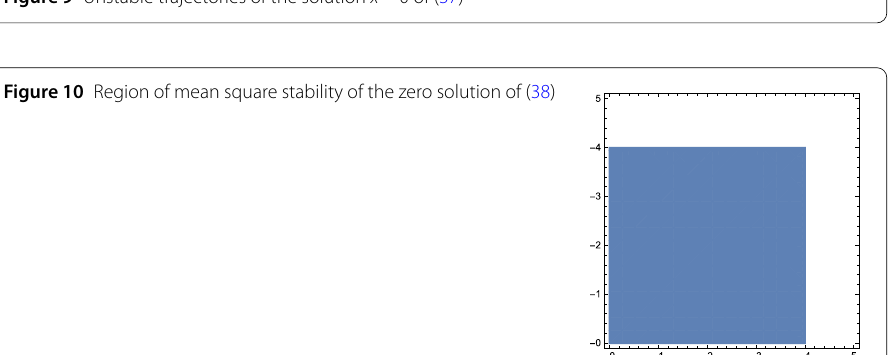
Figure 9 Unstable trajectories of the solution x = 0 of (37)